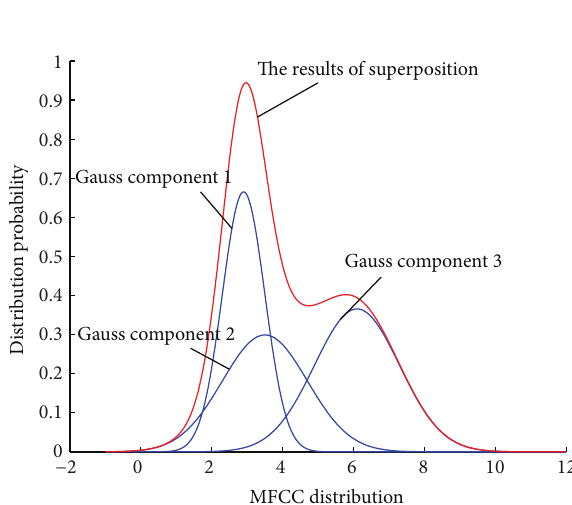
Figure 4: MFCC feature distribution.